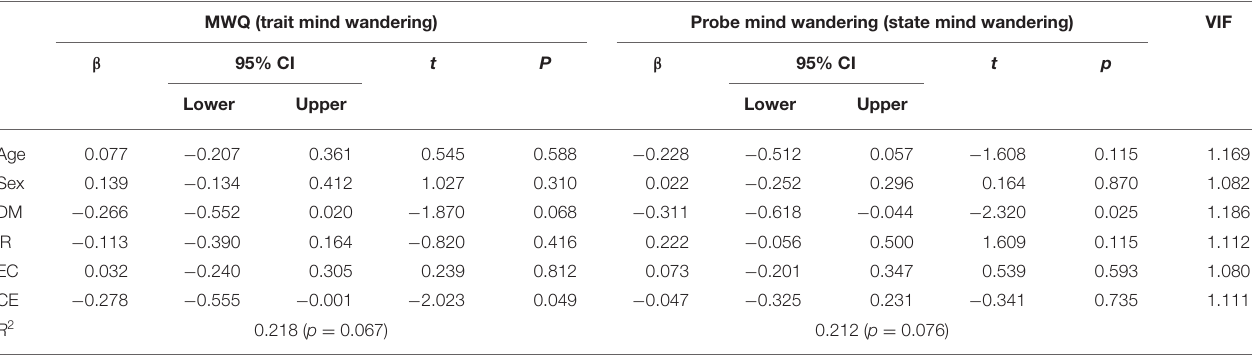
TABLE 2 | Multiple linear regression for the index of mind wandering ( n = 53).